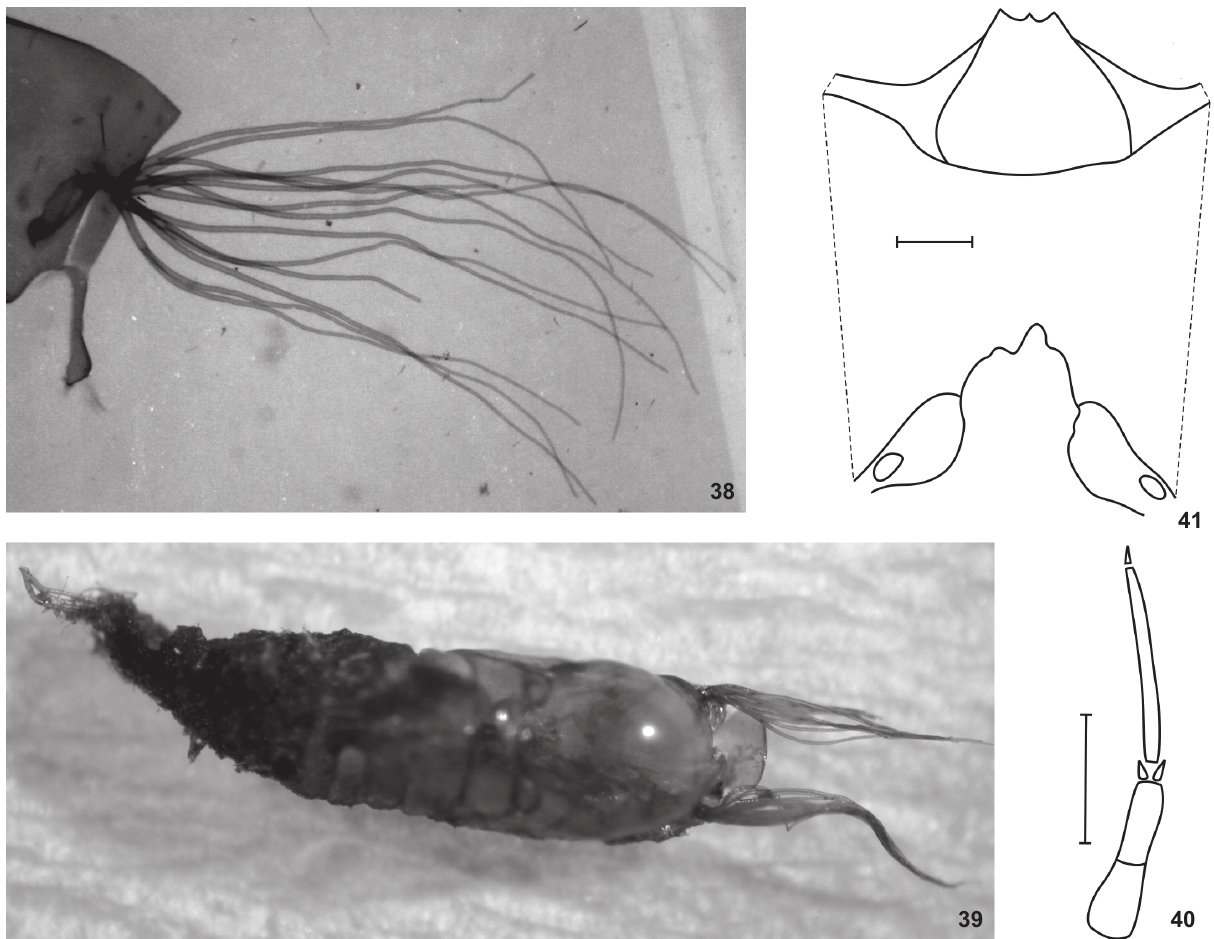
Figure 38-41. Immatures of L. pernigrum : (38-39 pupa) (38) gill; (39) pupa and cocoon. (40-41 larva) (40) antenna; (41) head capsule, ventral view. Bar: 0.1